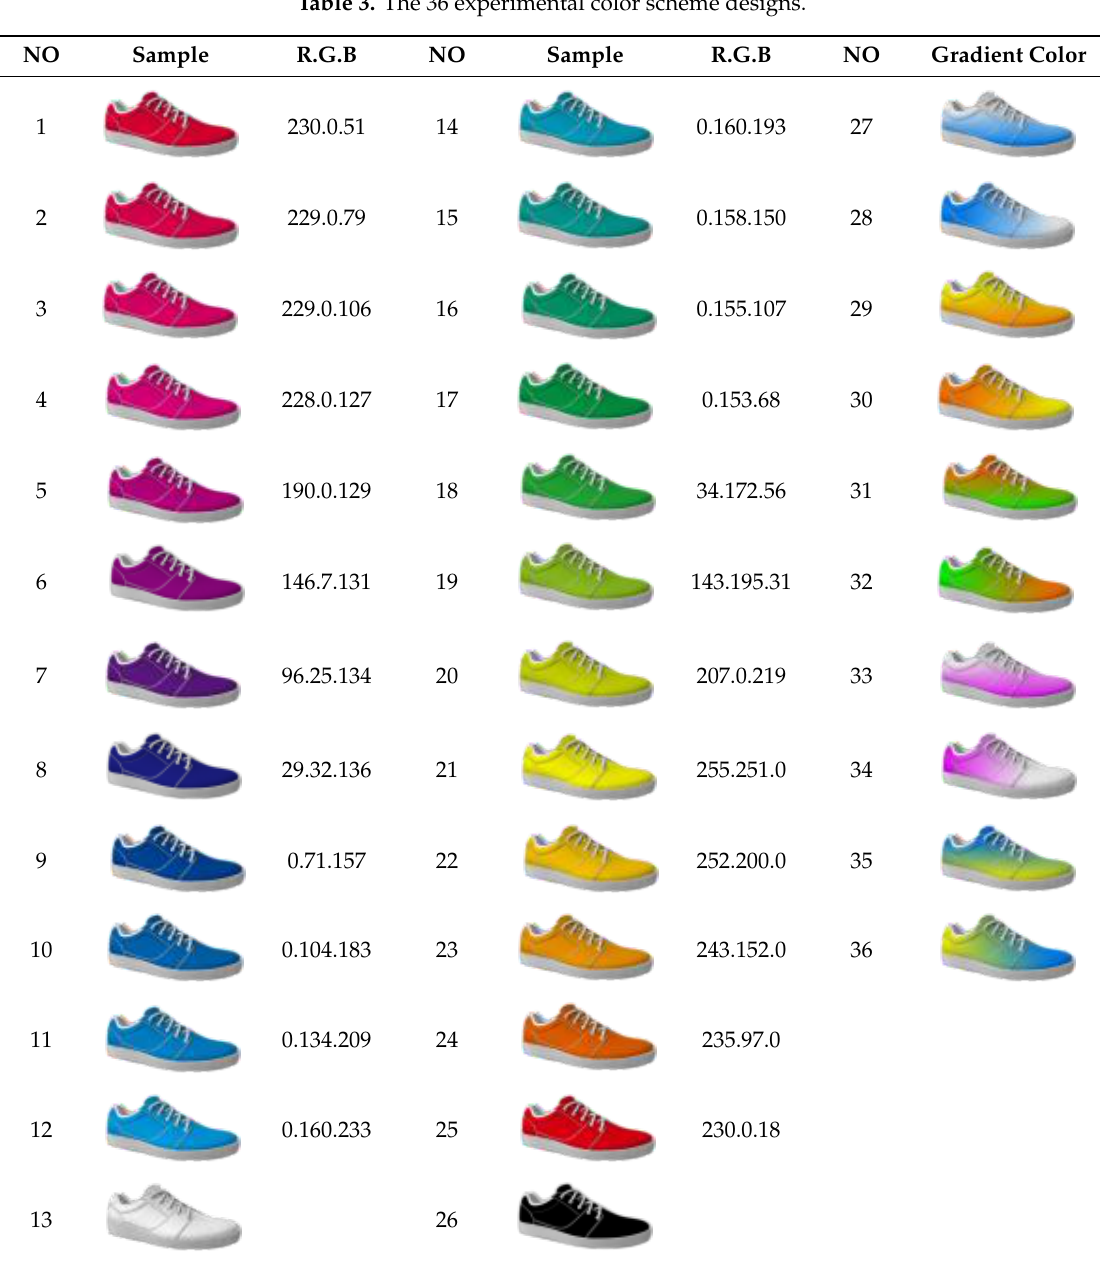
Table 4. Design factors and design factor levels for product forms of sports shoes.